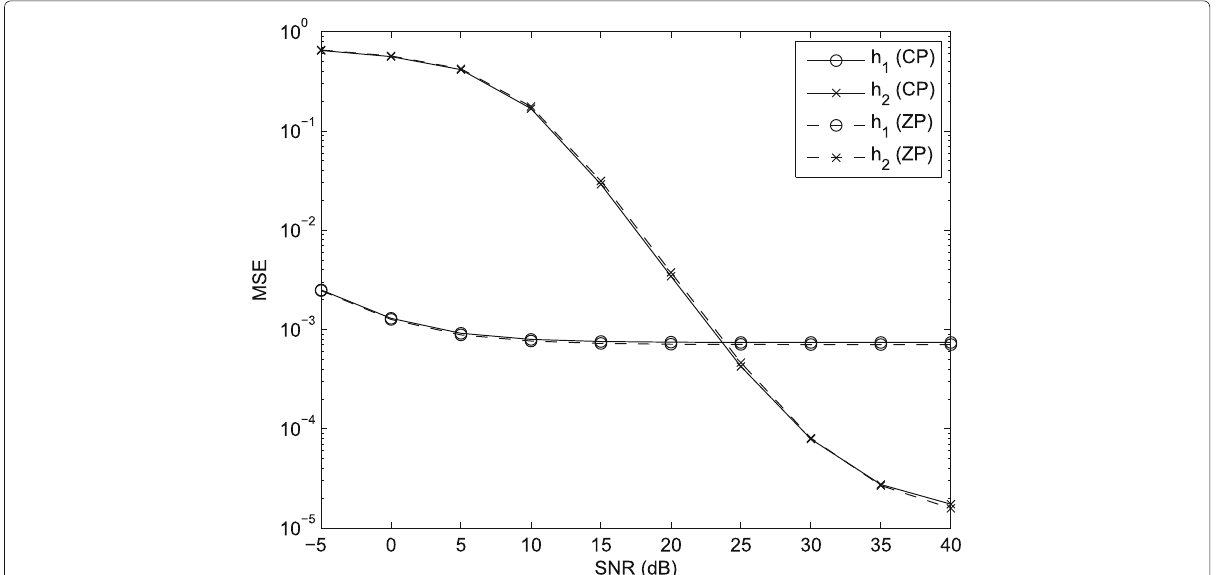
Fig. 8 Comparison of the normalized MSE for CP-OFDM and ZP-OFDM systems for K = 500. We compare the proposed algorithm for CP-OFDM and ZP-OFDM systems. The solid curves and the dashed curves represent the MSEs for CP-OFDM and ZP-OFDM, respectively. The number of received blocks is K =